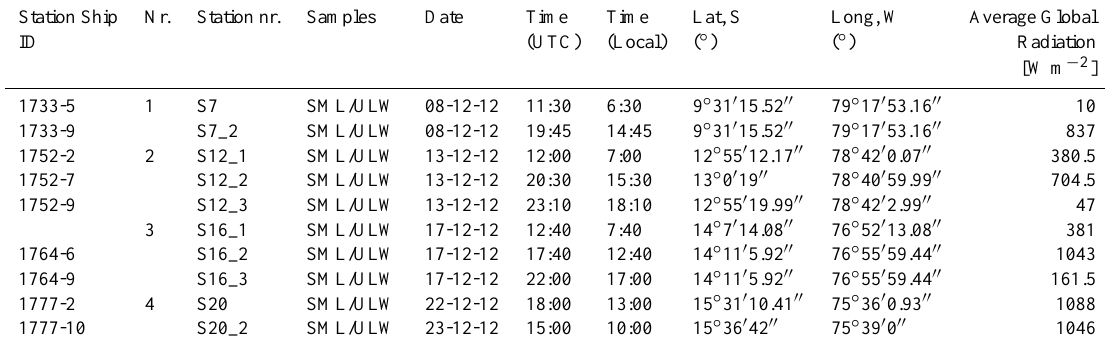
Table 2. Stations with multiple measurements. Metadata with date, local and UTC time of sampling, coordinates, and average global radiation retrieved from Dship data server of R/V Meteor . Station Ship Nr. Station